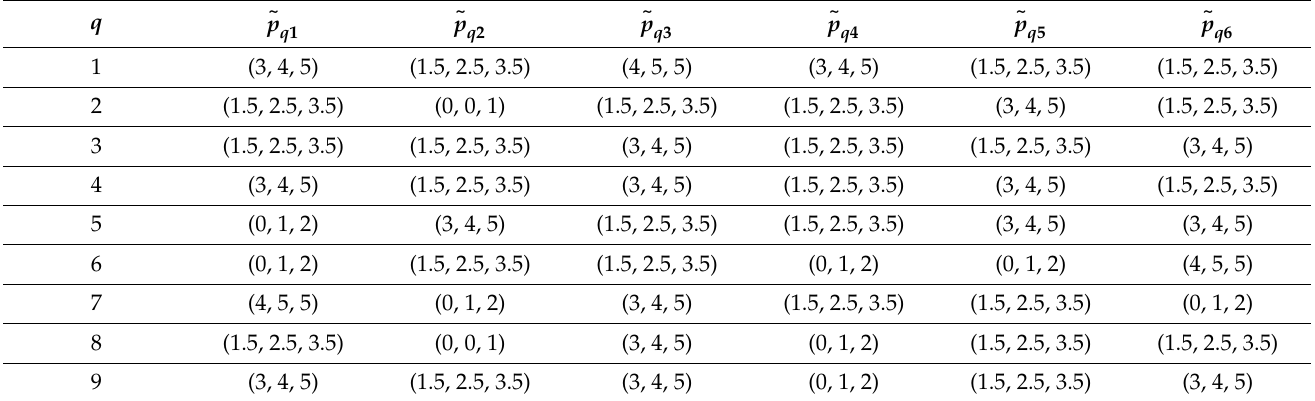
Table 6. Performances of smart technology